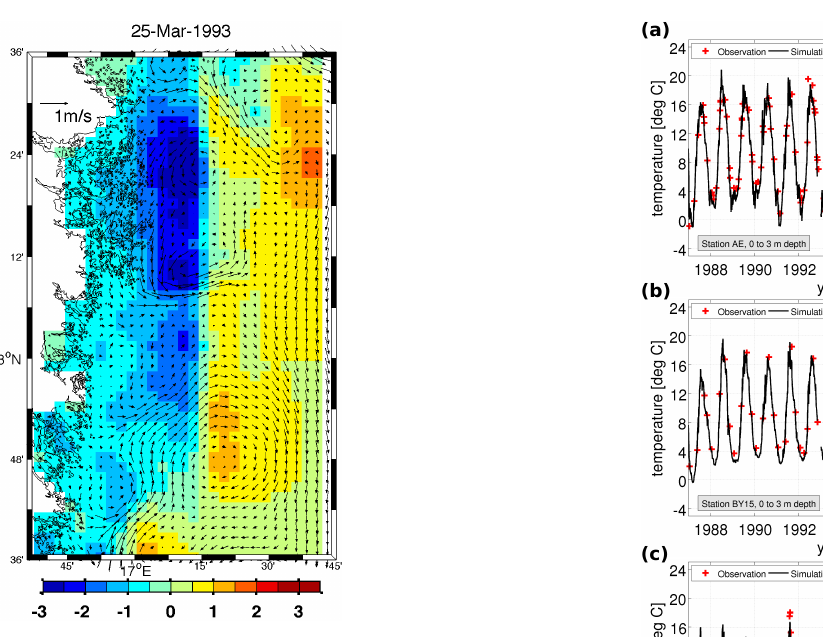
Figure 7. Daily mean Ekman pumping calculated from the curl of the wind stress in units day − 1 (in color) overlaid by surface currents (arrows) for an exemplary time slice. Strong upwelling is denoted in red. The calculation of the wind stress takes the ocean currents into account (as explained, e.g., in Eden and Dietze, 2009). Note, that the Ekman pumping features variabil- ity correlated with the surface currents on spacial scales much smaller than those that could possibly be effected by the ≈ 25 km resolution wind fields. Figure 8. Sea surface temperature at stations AE, BY15 and F9 in panels (a) , (b) and (c) , respectively. The positions of the respective stations are indicated in Fig. 1. Observations are from the Swedish Oceanographic Data Centre at SMHI (SHARK).